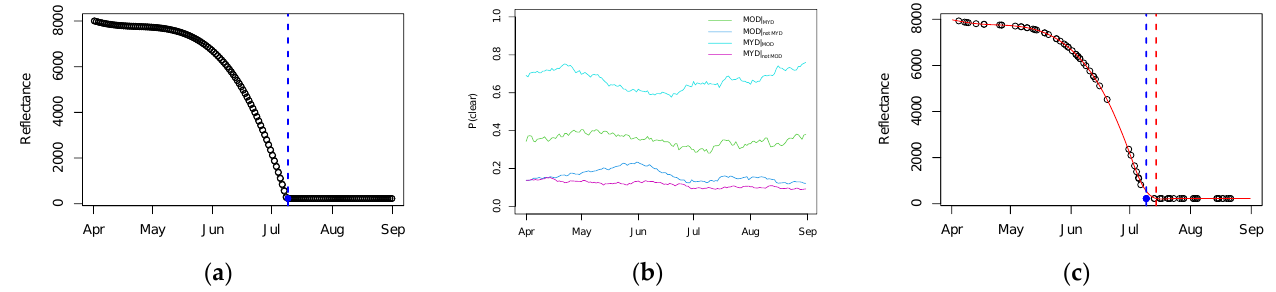
Figure 9. ( a ) Idealized seasonal time series of MODIS surface reflectance for Linnévatnet, based on the data from 2004 to 2019. The blue dot shows the surface reflectance at the BUE date, while the blue dashed line indicated the BUE date; ( b ) Markov transition matrix, as a function of day of year. MOD stands for the MODIS instrument on the Terra satellite, and MYD stands for the Aqua satellite. The four lines show the transition probabilities between clear and cloudy conditions (i.e., probability of a clear observation) for the two MODIS overpasses as a function of day of year, calculated using a 31-day window around the day-of-year across all years. For instance, MOD| MYD means the prob- ability that the Terra observation (10:30 local time) was clear, given that the previous Aqua obser- vation (13:30 local time on the previous day) was also clear. Similarly, MOD| not MYD is the probability that the Terra observation was clear, given that the previous Aqua observation was cloudy. ( c ) Same as ( a ), but with observations missing based on one realization of a Markov chain model of clear and cloudy conditions, where cloudy observations are removed. The red solid line is a smoothing spline fit to the remaining data, and the red dashed line is the inferred BUE date from the smoothing spline. The difference between the blue and red dashed lines represents the amount of error in the MODIS BUE estimate introduced by data loss due to cloudy conditions.